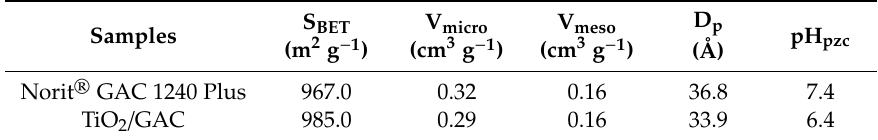
Table 2. Textural and chemical surface properties of the parent and modified GAC samples